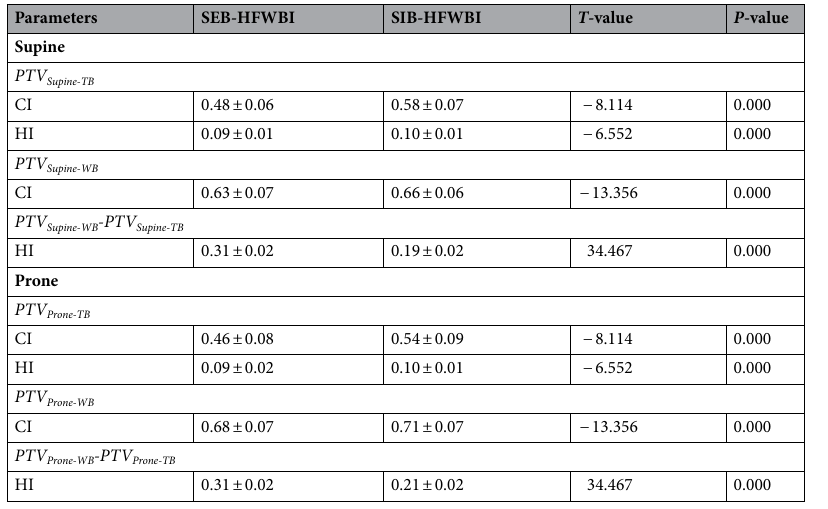
Table 3. Comparison of the CI and HI for the targets between SEB-HFWBI and SIB-HFWBI plans in the same position (mean). TB tumor bed, PTV TB planning target volume for the TB, WB whole breast, PTV WB planning target volume for the WB, SIB simultaneous integrated boost, SEB sequential integrated boost, HFWBI hypofractionated whole-breast irradiation, CI conformal index, HI homogeneity index, PTVsupine- WB -PTVsupine- TB the target volume obtained by subtracting the PTV TB from the PTV WB in supine position, PTVprone- WB -PTVprone- TB the target volume obtained by subtracting the PTV TB from the PTV WB in prone position.